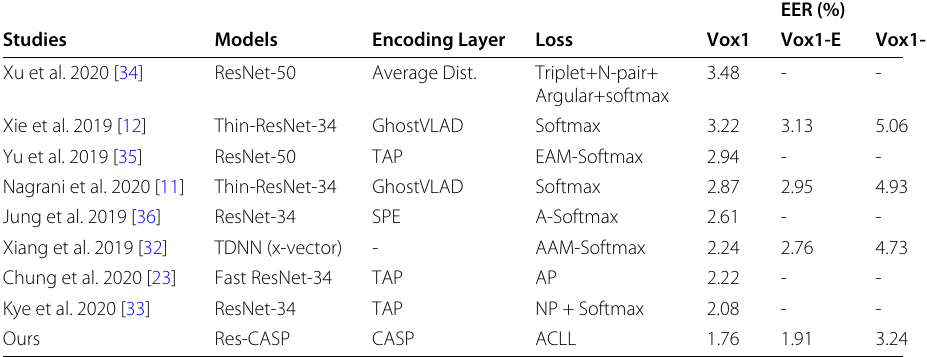
Table 4 Comparison of text-independent speaker recognition with related methods in recent years